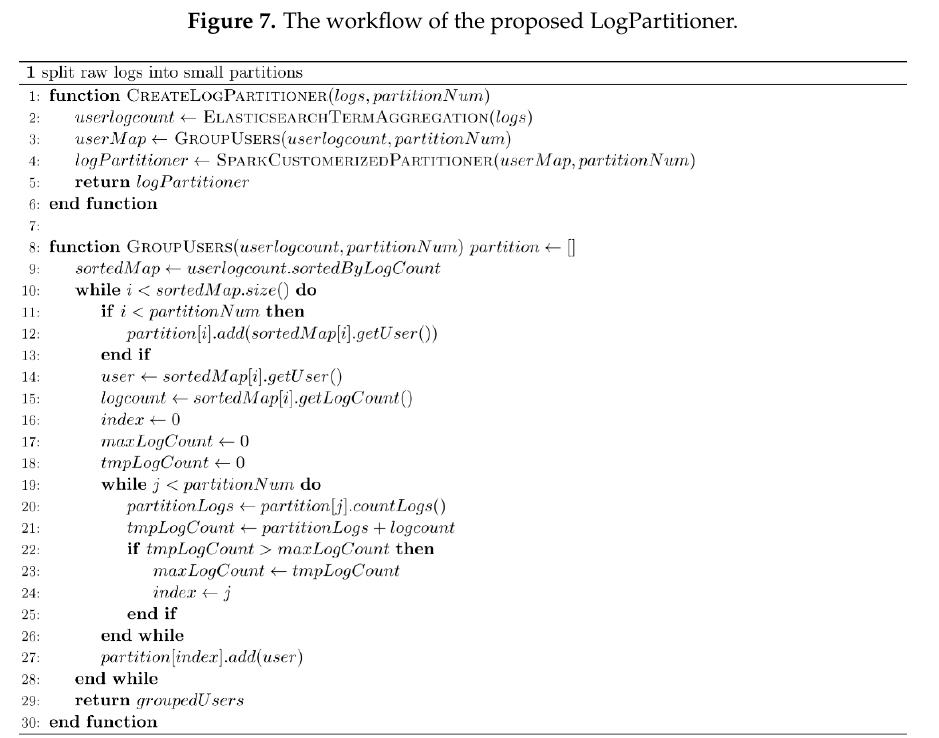
Figure 8. The pseudo code of the LogPartitioner.